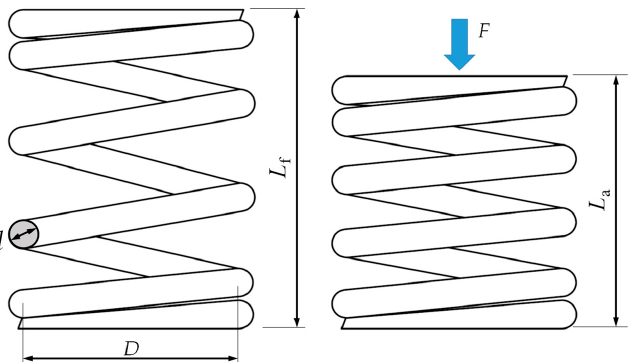
Figure 9. Configuration and dimensional parameters for helical coil spring.